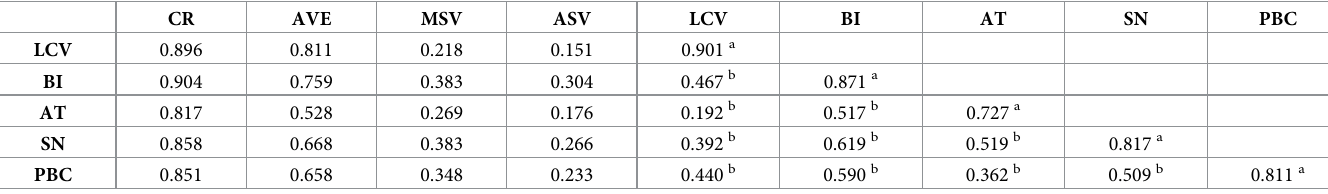
Table 11. Construct reliability, convergent validity, and discriminant validity.